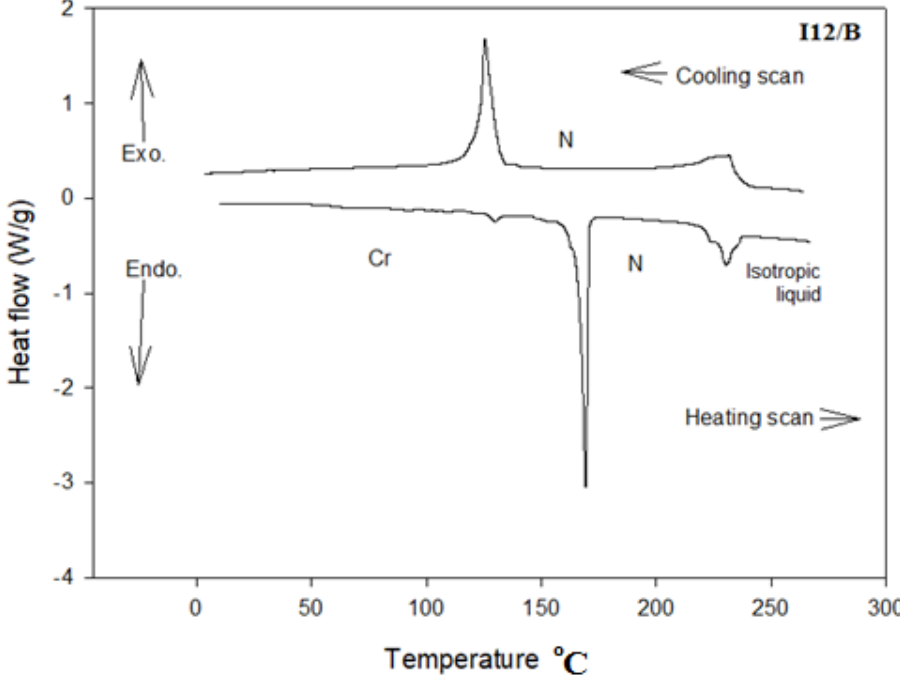
Figure 3. DSC thermograms on the second heating/cooling cycles of the 2:1 supramolecular H-bonded (SMHB) complex I12/B at a rate of 10 °C/min.